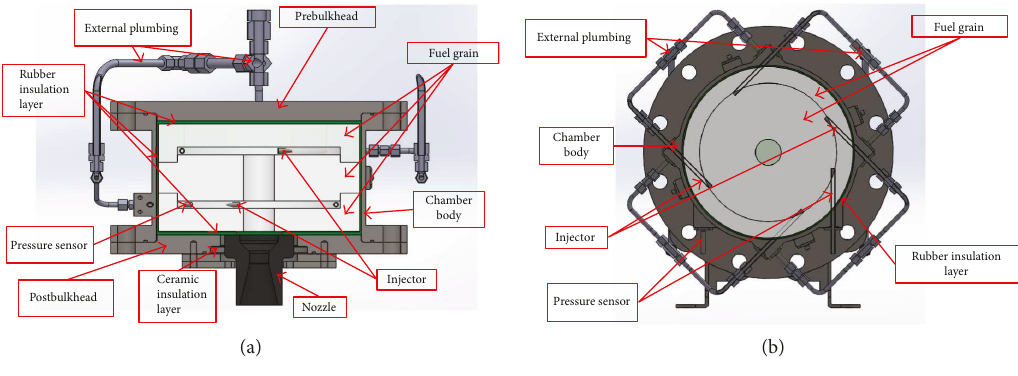
Figure 3: Detailed design of 250kgf class DVF engine.